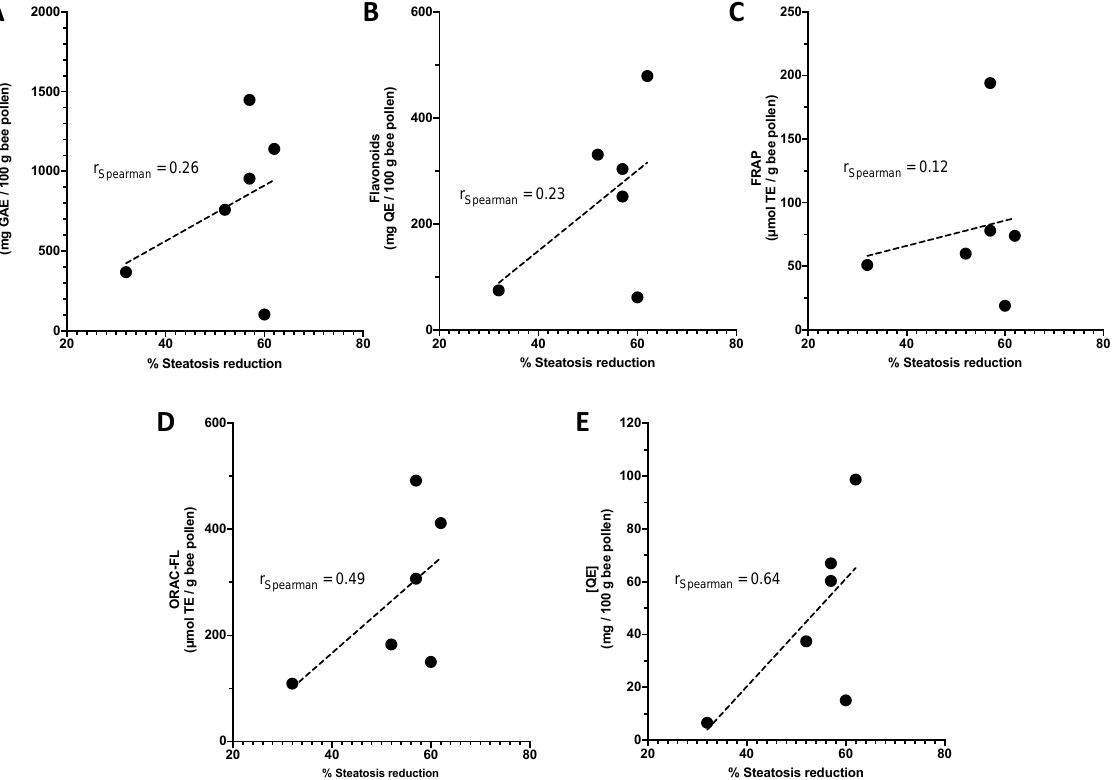
Figure 4. Correlation coefficient (ρ) from Spearman correlation analysis between hepatoprotective effects and ( A ) total phenols content, ( B ) flavonoid content, ( C ) antioxidant capacity (FRAP), ( D ) antioxidant capacity (ORAC-FL), and ( E ) quercetin concentration [QE].